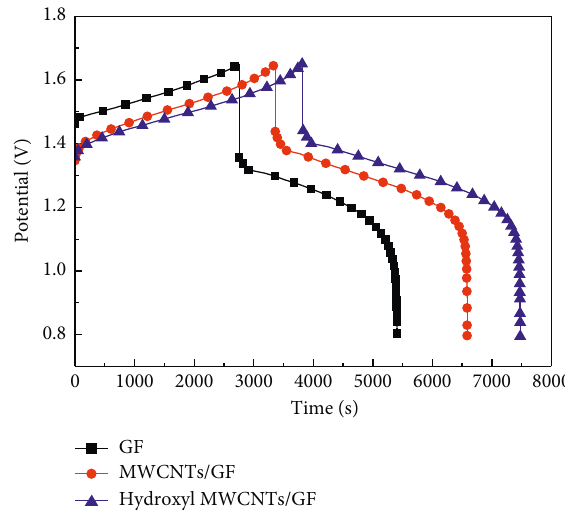
Figure 7: Charge-discharge curves of different electrodes. Table 5: Efficiency of cells equipped with different electrodes.